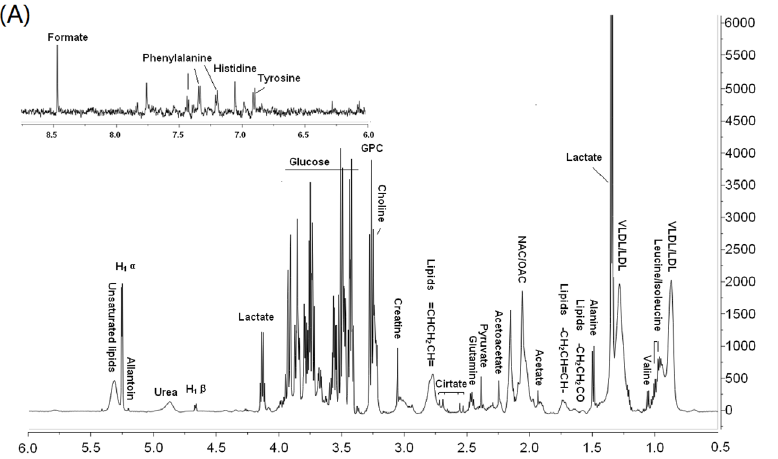
Figure 1. Representative 600 MHz 1 H nuclear magnetic resonance spectroscopy ( 1 HNMR) spectra ( δ 10–0.5 ppm) of plasma ( A ) and urine sample ( B ) in sham rats. GPC: glycerophosphatide choline; TMAO: Trimethylanine-oxide; OAC: O -acetyl-glucoprotein; NAC: N